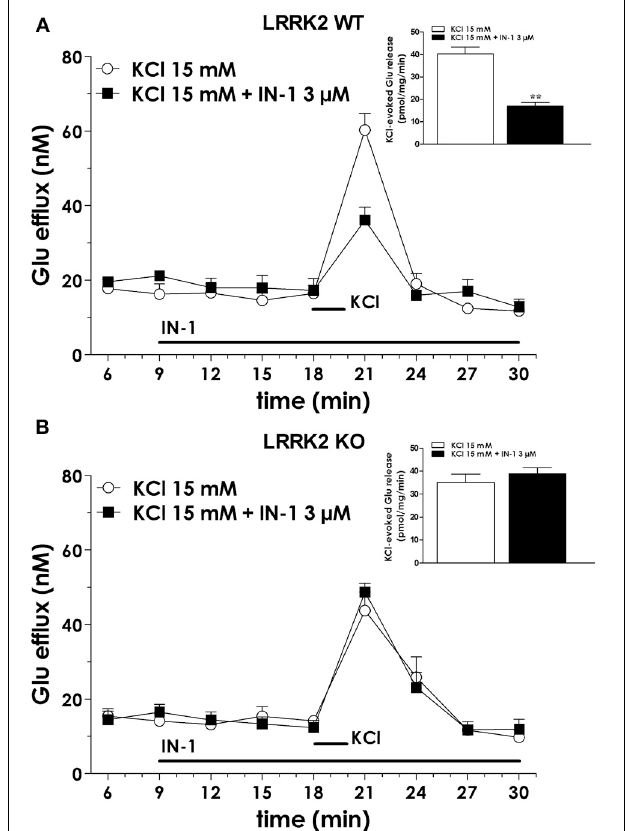
FIGURE 3 | IN-1 impairs neurotransmitter release from isolated synaptosome. (A) Synaptosomes obtained from the cerebral (fronto-temporal) cortex of LRRK2 WT mice were perfused with Krebs solution, and stimulated with a 90s pulse of 15mM KCl. IN-1 (3 µ M) was perfused 9min before KCl and maintained until the end of experiment. IN-1 reduced K + -evoked glutamate overflow. Data are means ± s.e.m. of 5–6 determinations per group, and are expressed as absolute glutamate concentrations in the superfusate (in nM) or K + -evoked glutamate overflow (in pmol/mg protein/min; insets). (B) Similar experiments were executed on cortical synaptosome obtained from LRRK2 KO mice. IN-1 (3 µ M) failed to impair K + -evoked glutamate overflow. Statistical analysis was performed on overflow values by the Student t -test for unpaired data. ∗∗ p < 0 . 01 different from KCl